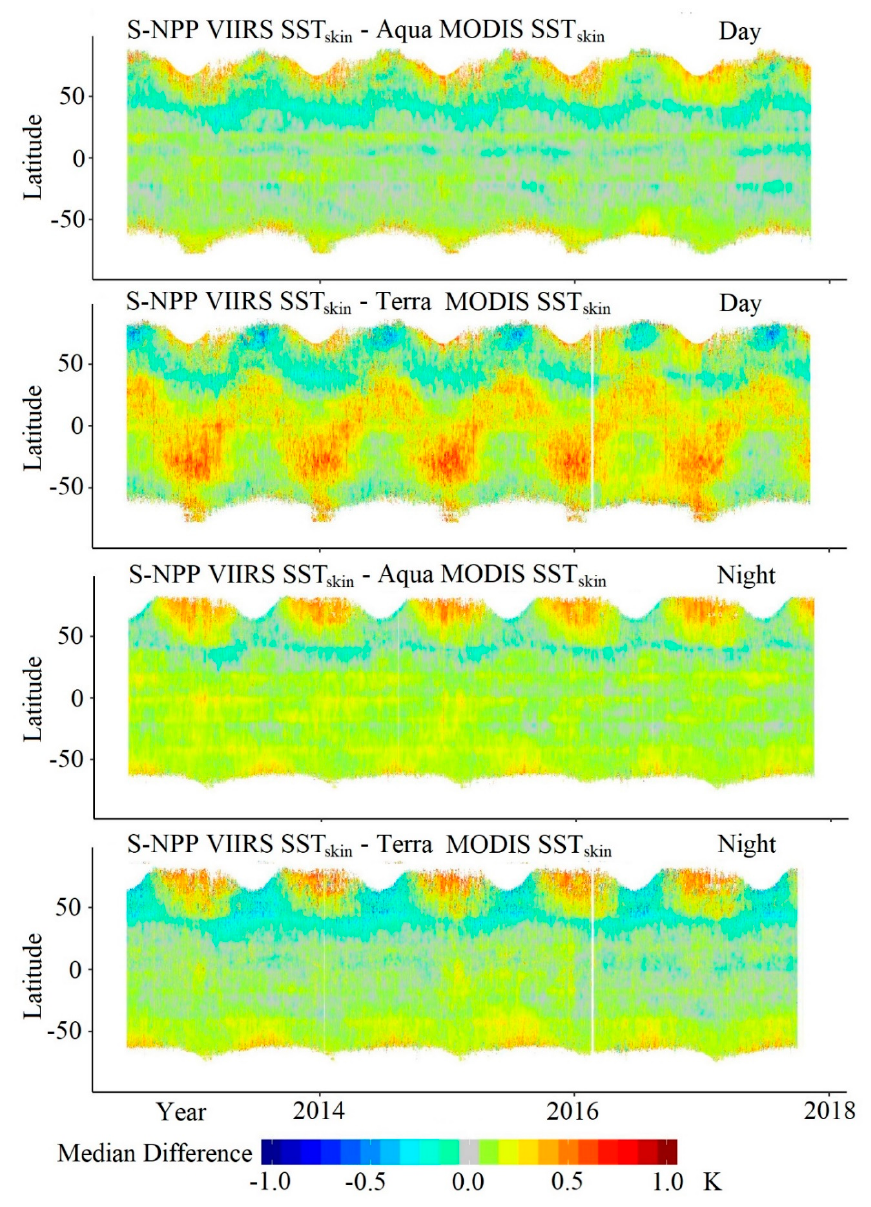
Figure 16. Hovmöller plots of daily differences in the zonal averages of SST skin derived by S-NPP VIIRS and MODIS on Terra and Aqua.